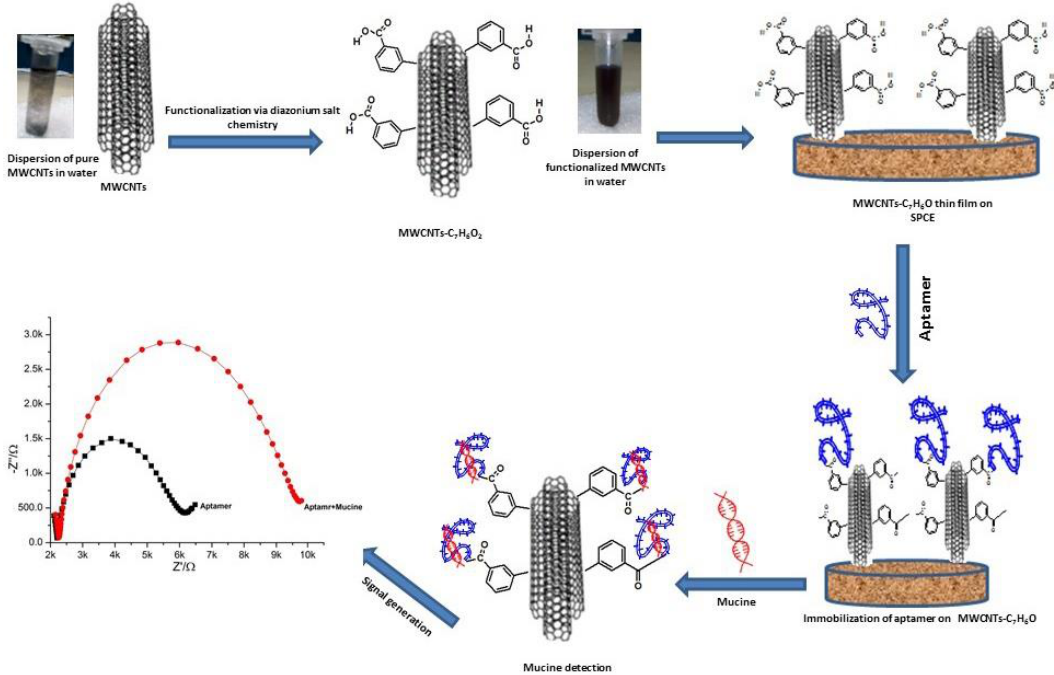
Figure 5. Schematic presentation of thin film assembly of carbon nanotubes on screen printed interface for electrochemical aptasensing applications.